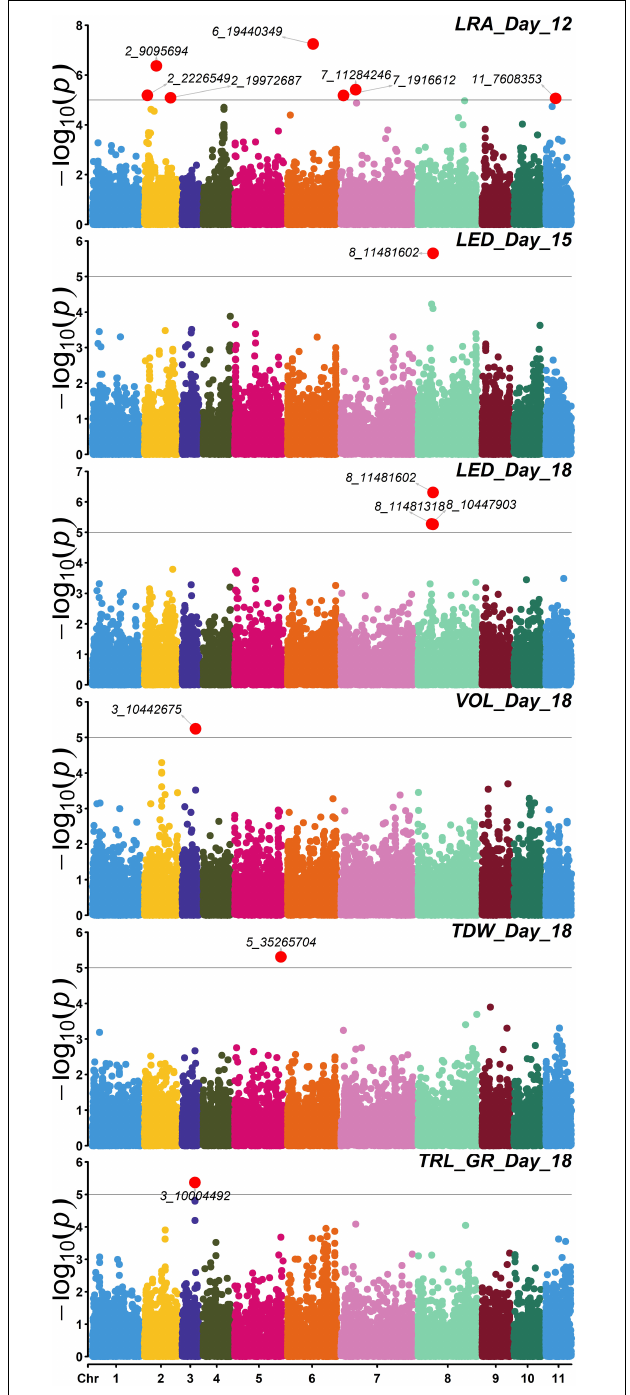
FIGURE 8 | Manhattan plots of –log10( p ) vs chromosomes of SNP markers associated with the mung bean traits lateral root angles (LRA) (day 12), length distribution (LED) (day 15), and volume (VOL), LED, total dry weight (TDW), total root length-growth rate (TRL_GR) for day 18. The threshold line is the Bonferroni correction at p = 0.05 [at –log10( p ) = 5]. Significant SNPs are highlighted in red and annotated with the marker name. Trait—SNP associations performed using the Trait Analysis by aSSociation, Evolution, and Linkage (TASSEL)